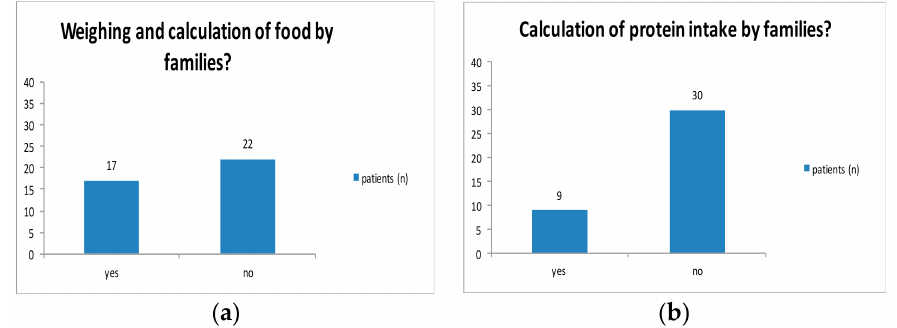
Figure A1. Weighing and calculation of food. Special low-protein products were taken by 15 patients regularly. 15 patients stated to take them irregularly, whereas 6 patients rarely or never used low-protein products (Figure A2). Normal bread was eaten by 21 patients, 11 patients consumed normal bread irregularly and 7 rarely or never ate normal bread. Normal pastries were taken rarely or never by 18 patients, 11 patients took normal pastries regularly and 7 cases irregularly. 25 patients consumed protein-rich food rarely or never while 3 patients ate it regularly and 11 families admitted an irregular intake (Figure